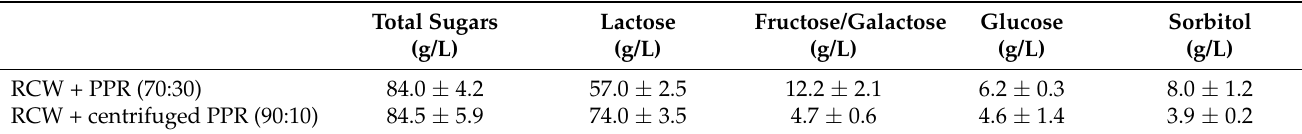
Table 5. Sugar composition of the mixtures of RCW + PPR (70:30) and RCW + centrifuged PPR (90:10). Total Sugars